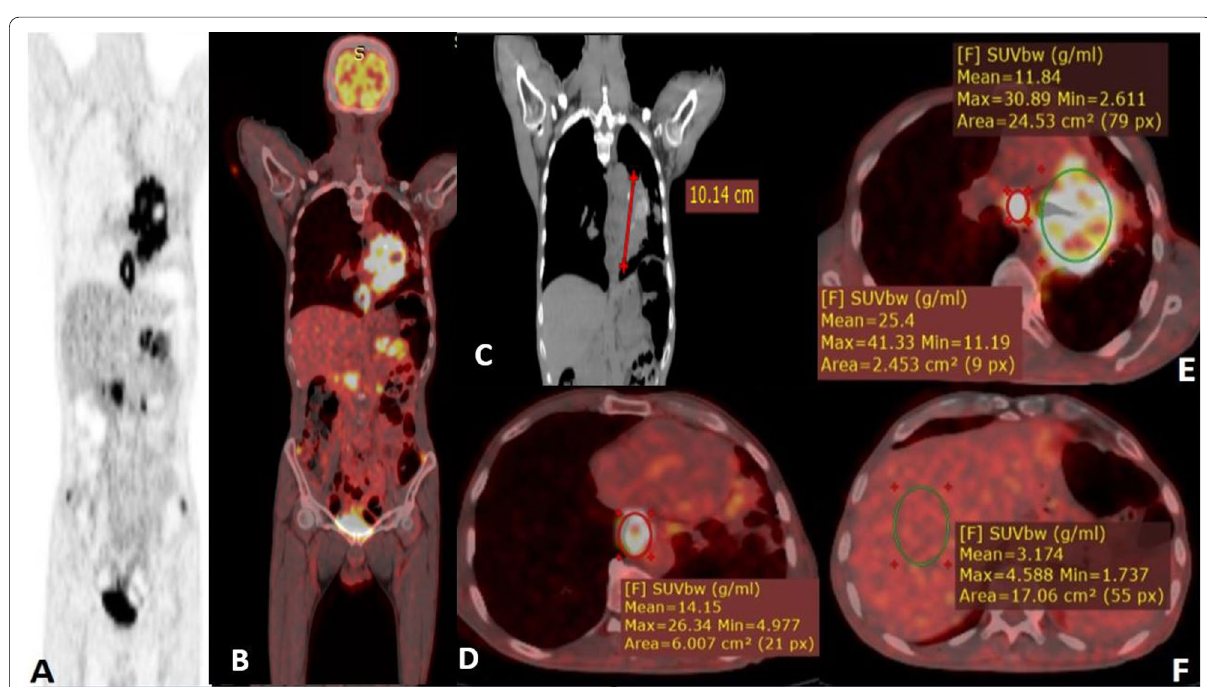
Fig. 5 A 59-year-old male patient proved histopathologically to have squamous cell carcinoma (SCC) involving the left upper lobe. A (coronal PET), B (coronal PET/CT), C (coronal CT in a mediastinal window), D , E , and F images (axial PET/CT images). The mass lesion size measured in the C image was 10.1 cm with SUVmax of the tumor was 30.9 as shown in E . TLR was calculated to be 30.9/4.58 6.75. Para-esophageal ( D ) and Subcarinal ( E ) = lymphadenopathies noted with SUVmax 26.34 and 41.33, =